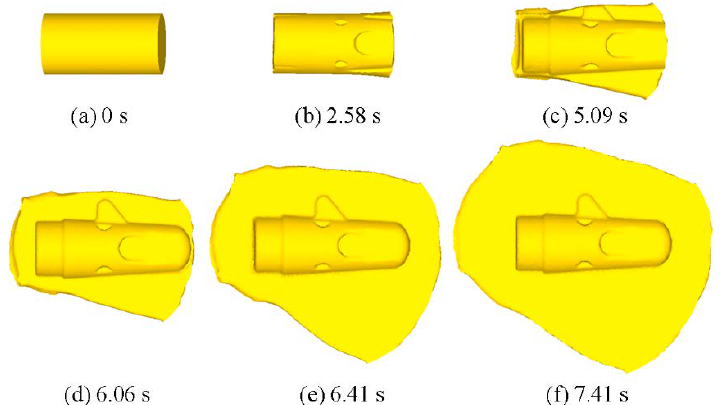
Figure 9. Forming shape evolution of top part of component with length of 58 mm under different forming time during cold orbital forming: ( a ) t = 0 s; ( b ) t = 2.58 s; ( c ) t = 5.09 s; ( d ) t = 6.06 s; ( e ) t = 6.41 s; ( f ) t = 7.41 s.